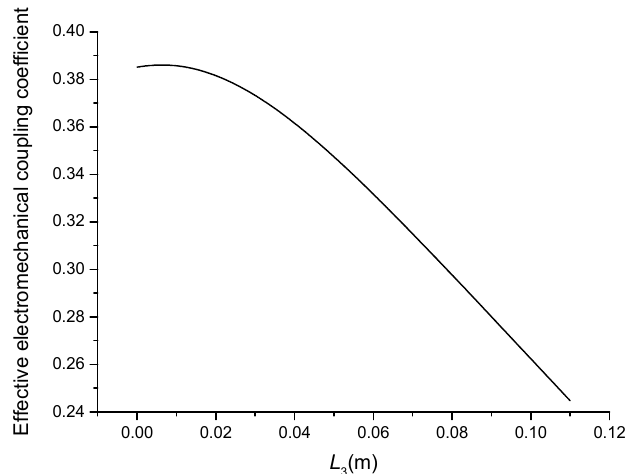
Figure 12. Theoretical relationship between the effective electromechanical coupling coefficient and length L 3 at the fundamental mode (Position effect of PZT-3).